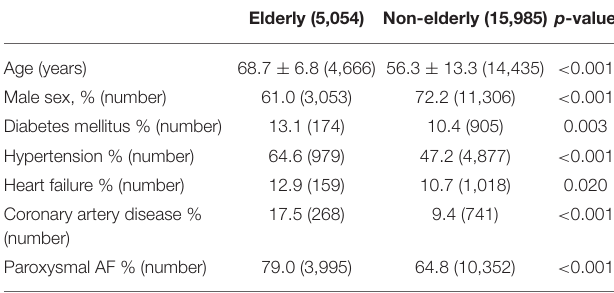
Pooled Odds Ratio of Recurrent Atrial Fibrillation or Atrial Tachyarrhythmia After Ablation in the Elderly vs. Non-elderly Groups The overall OR of recurrent AF or atrial tachyarrhythmia